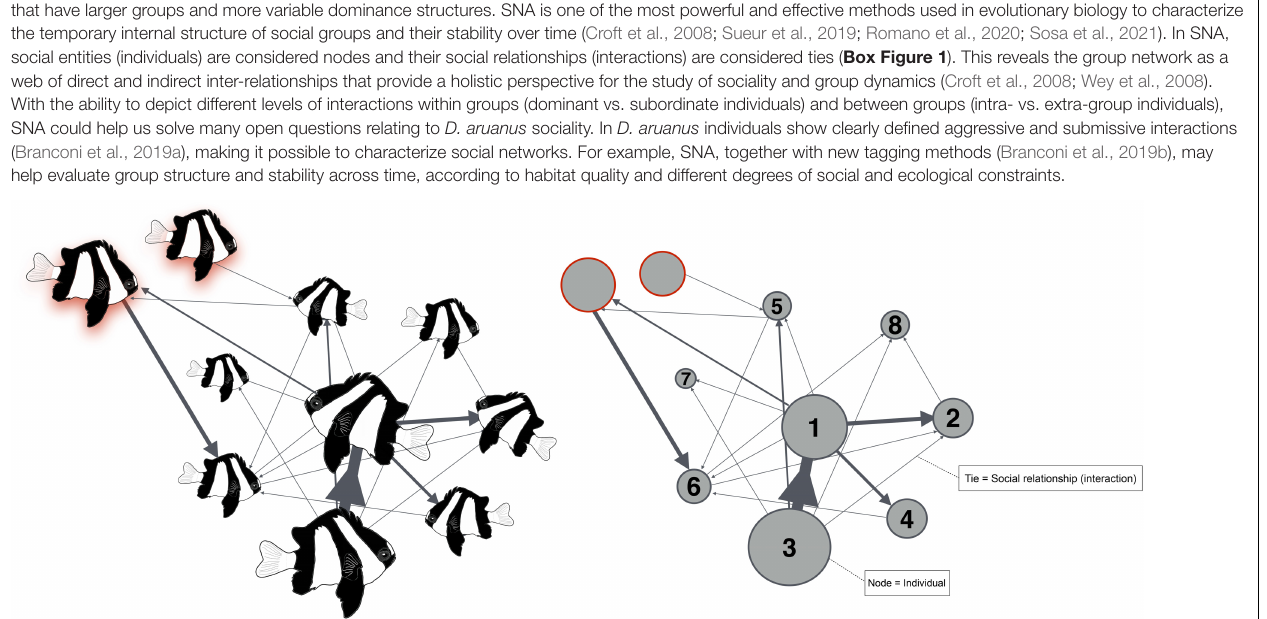
BOX FIGURE 1 | Hypothetical weighted and directed social network of a small group of Dascyllus aruanus . The thickness of the ties (interactions) is proportional to the strength of the connection between the individuals, and the size of the nodes (individuals) is proportional to their respective number of social interactions. Numbers denote individual ID. Red shaded individuals/nodes denote extra-group